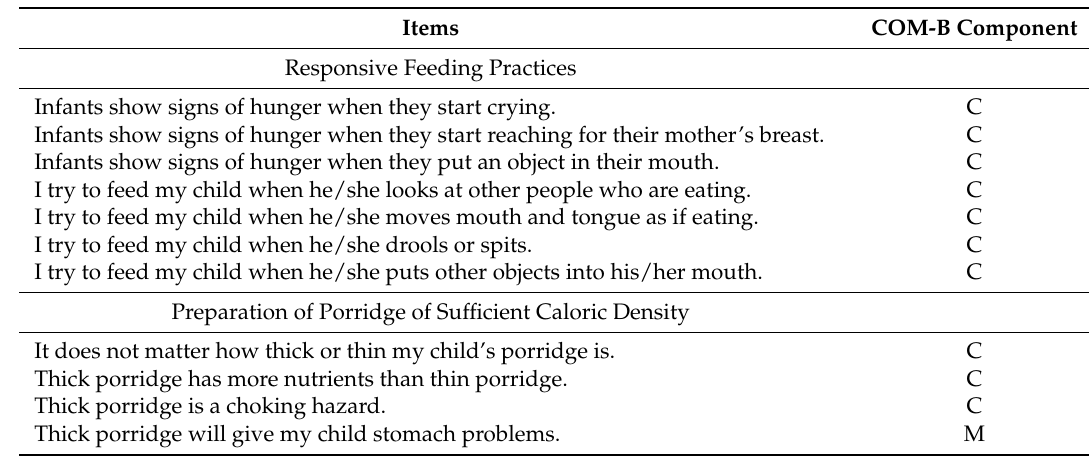
Table A2. All items related to caregiver behaviors surrounding responsive feeding practices and preparation of porridge of sufficient caloric